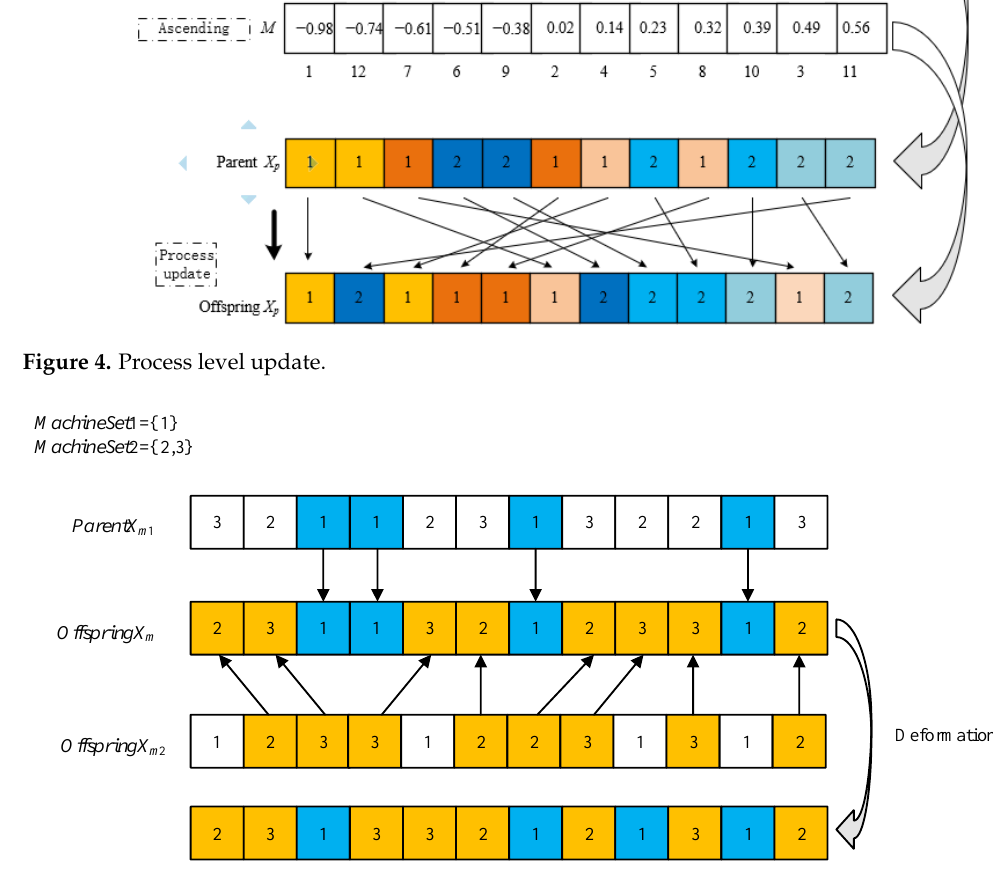
Figure 5. Swap and deformation diagram.